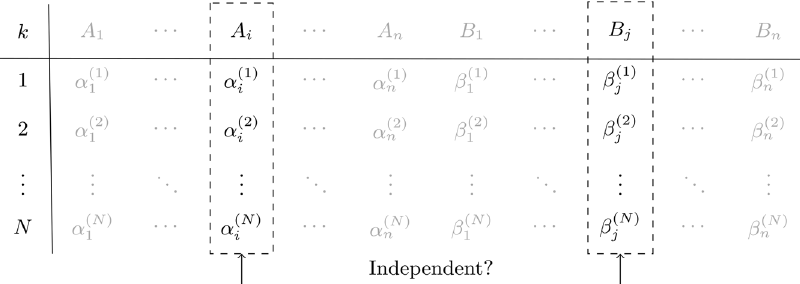
Fig. 5 Matrix of measurement outcomes. Each row corresponds to a query to the process, and each column corresponds to an input or output wire. When we investigate A i and B j , we only look at the corresponding columns in the matrix and check the independence from data in these